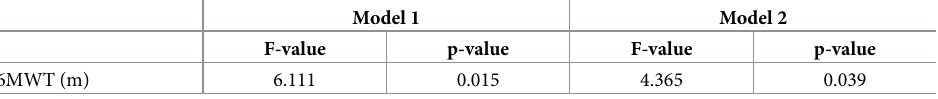
Table 7. Adjusted least squares linear regression model of the 6MWT on comorbidity (Davies comorbidity scale 0–7).